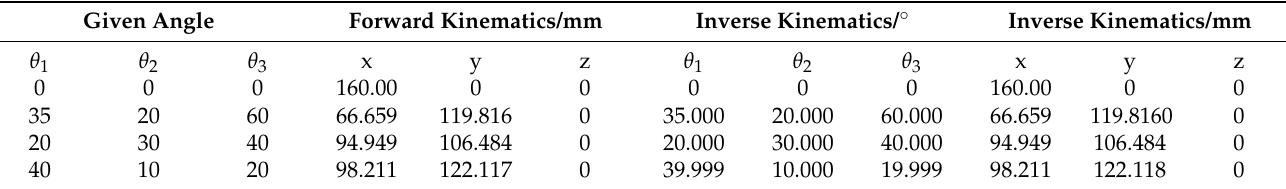
Table 2. Inverse kinematic verification